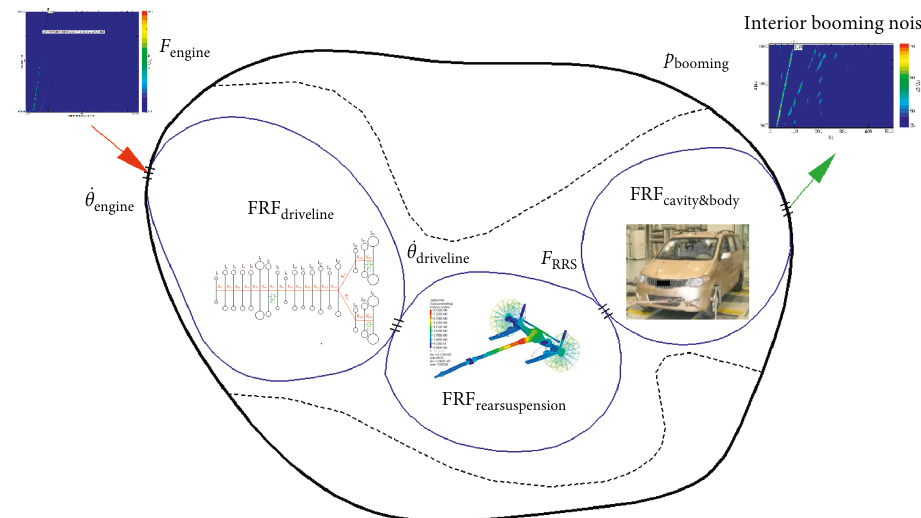
Figure 20: Mechanism of minivan interior booming noise.